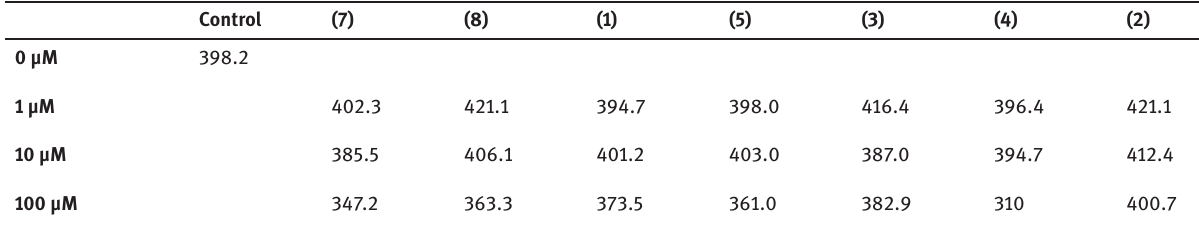
Table 6 : The RNA MFI (mean fluorescence intensity) of HL60 cells in G1 phase of cell cycle stained with AO and analyzed by flow cytometry.